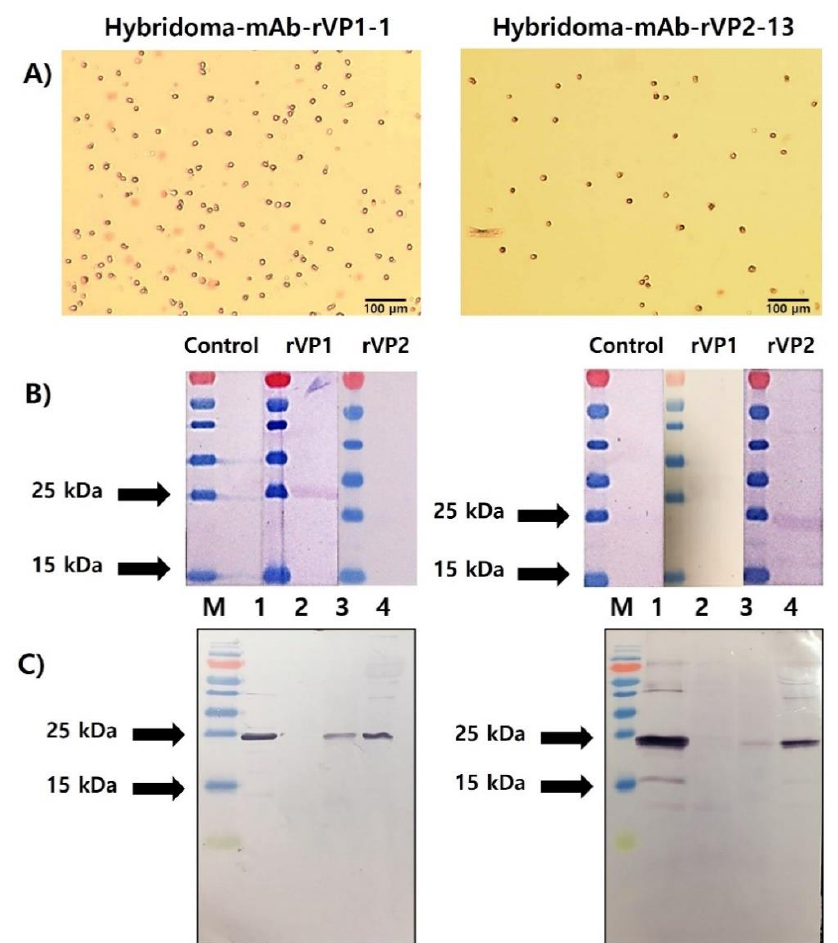
Figure 4. ( A ) Hybridoma clones with the highest titer of anti-rVP1 (left) and anti-rVP2 (right); ( B ) screening by Western blot analysis showed that mAb-VP1-1 and mAb-VP2-13 reacted strongly against rVP1 and rVP2, respectively; and ( C ) immunoreactivity of mAb-VP1-1 and mAb-VP2-13 with field samples in Western blotting. Lane 1: the purified recombinant protein (rVP1, rVP2); lane 2: healthy honeybees, lane 3: infected honeybees; and lane 4: infected larvae.